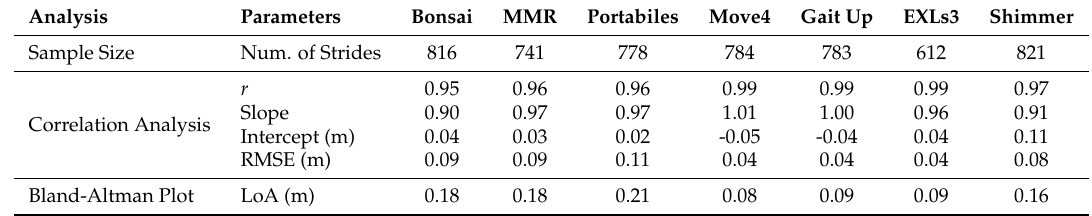
Table 8. Evaluation of stride lengths derived from IMU data with correlation analysis and Bland-Altman Plot. Analysis Parameters Bonsai MMR Portabiles Move4 EXLs3 Shimmer Sample Size Num. of